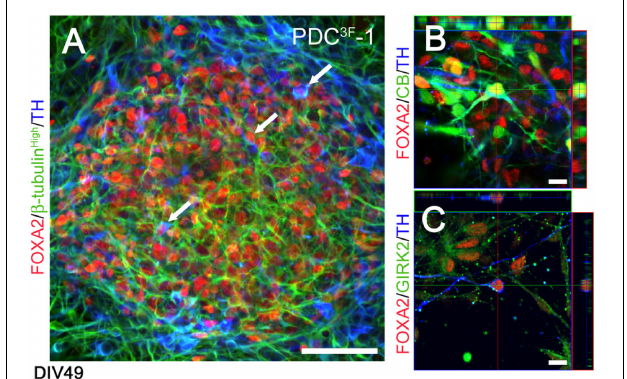
FIGURE 5 | Phenotypic characterization of FOXA2 + dopaminergic neurons generated by the differentiation protocol described in Cooper et al. (2010) at DIV49. (A) Human iPSCs generate FOXA2 + (red) dopaminergic neurons (TH, blue; β -tubulin, green; arrowheads). (B,C) Cells co-expressed TH (blue), FOXA2 (red) and calbindin (green, B) or GIRK2 (green, C), indicative of an A10 or A9 DA neuron phenotype, respectively. Scale bar (A) = 50 µ m, (B,C) = 10 µ m. Reprinted from Cooper et al. (2010) with permission from